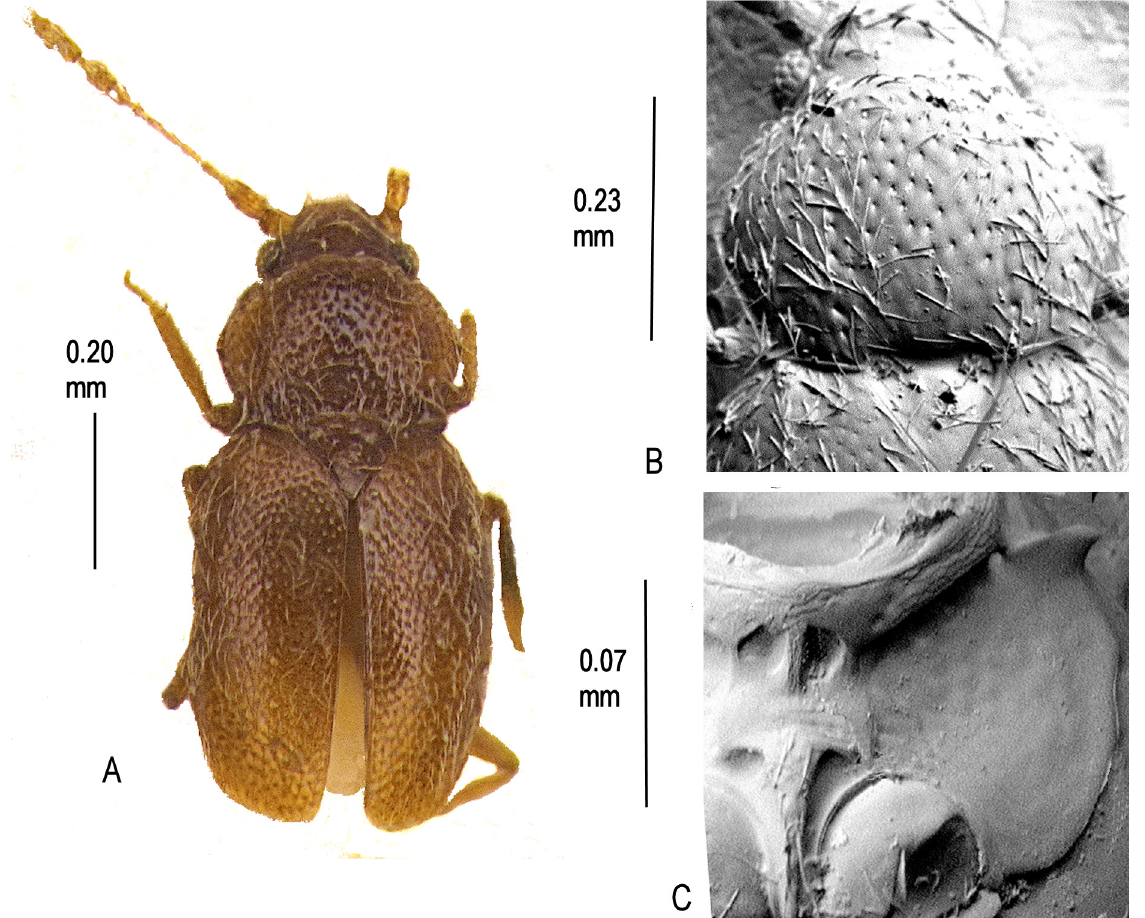
Fig. 61 . Cissidium puncticolle sp. nov. A . Habitus. B . Pronotum, × 425. C . Mesoventrite showing median process of collar, mid-keel, keel and lateral margin with very protuberant humerus, ×